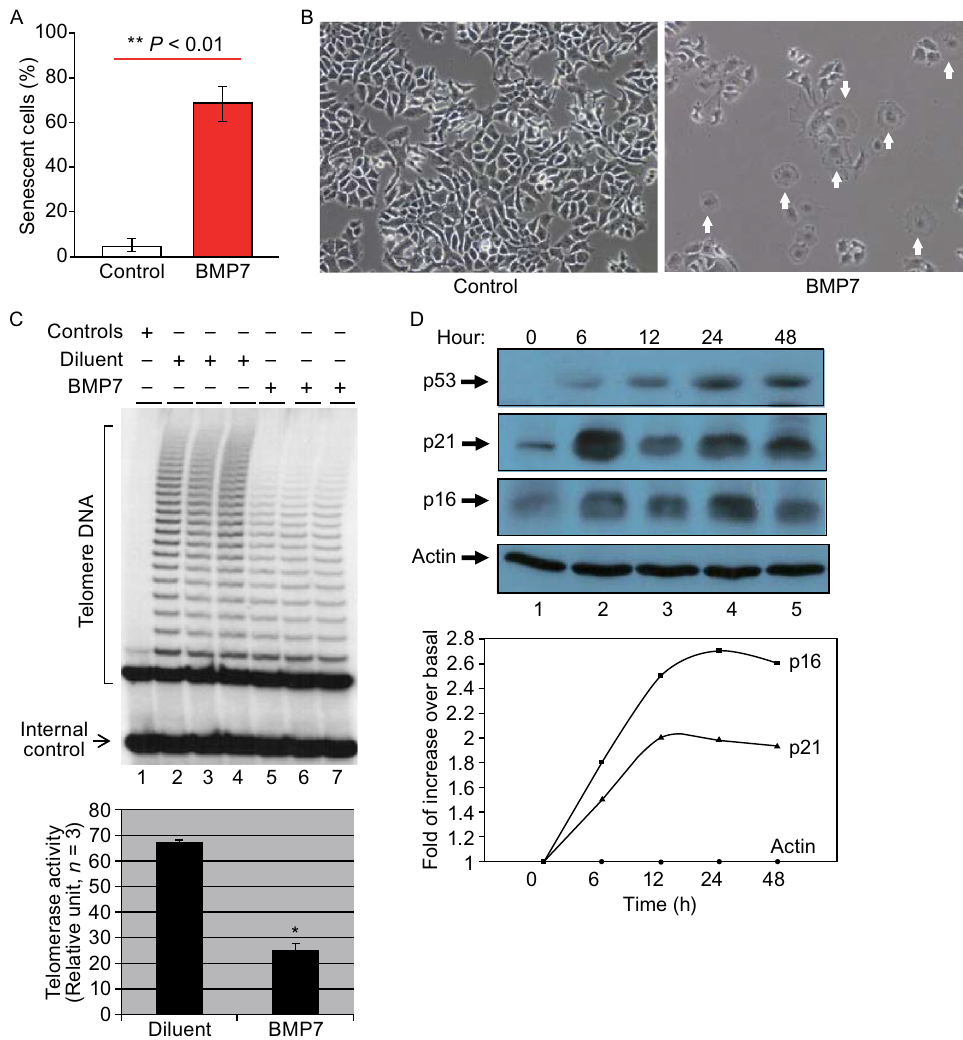
Figure 2. BMP7 induces cancer cell senescence. (A) BMP7 induces an increase in cancer cell senescence. MCF-7 cells were incubated with or without BMP7 (30 ng/mL) for 15 h three times a week for two weeks. Senescence-like cells were counted in multiple micrographs and presented as means with comparison between the control and BMP7-treated groups. The results are in mean ± SD from fi ve determinations. (B) Representative micrographs of cultured MCF-7 cells photographed under phase contrast microscope at 10X magni fi cation. Senescence-like cells are indicated by arrows. (C) Inhibition of telomerase activity in MCF-7 cell cultures treated with BMP7 for 15 h three times a week for two weeks. The result was from one of two assays. (D) Increases in p16, p53 and p21 in the MCF-7 cells treated with BMP7 (10 ng/mL) for different periods of time, determined by Western blotting. The data presented in top panel were from one of two similar experiments, and the data in bottom panel are means of two